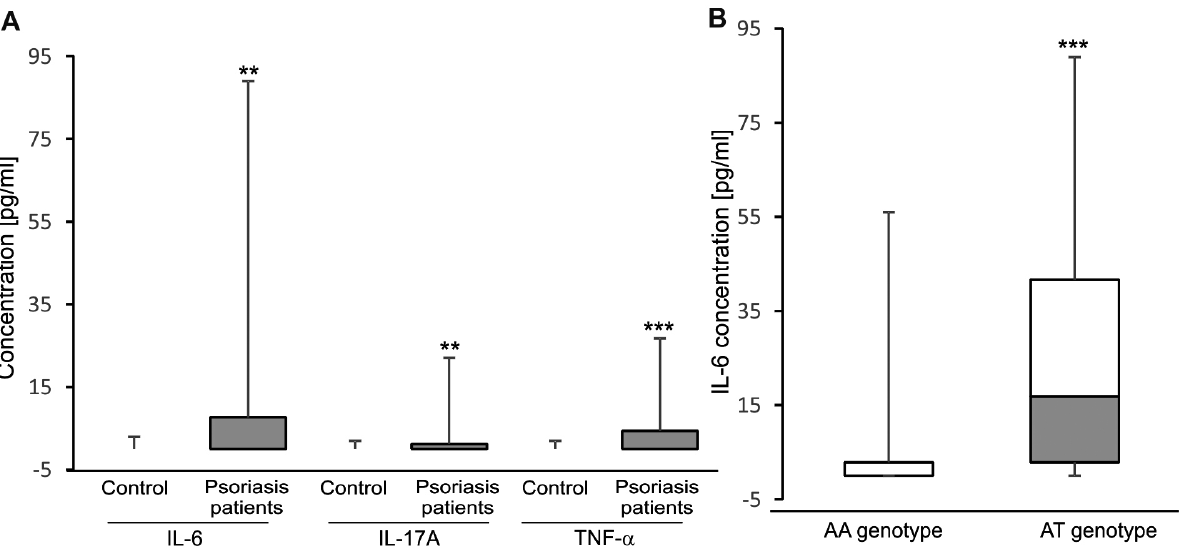
Figure 5 - Expression of inflammatory cytokines in psoriatic patients. A: Arithmetic means ± SEM ( n = 46-71) of IL-6, IL-17A and TNF-α concentrations are attained from sera of healthy donors and psoriatic patients. ** (p<0.01) and *** (p<0.001) indicate significant differences from healthy donors (Mann–Whitney U test). The box plots denote the median, IQR and minimum and maximum values. B: Arithmetic means ± SEM ( n = 11-60) of IL-6 concentration is attained from sera of psoriatic patients carrying the AA or AT genotype of SNP rs1018673641 in TLR4 gene. *** (p<0.001) indicates significant difference from the AA genotype (Mann–Whitney U test). The box plots denote the median, IQR and minimum and maximum